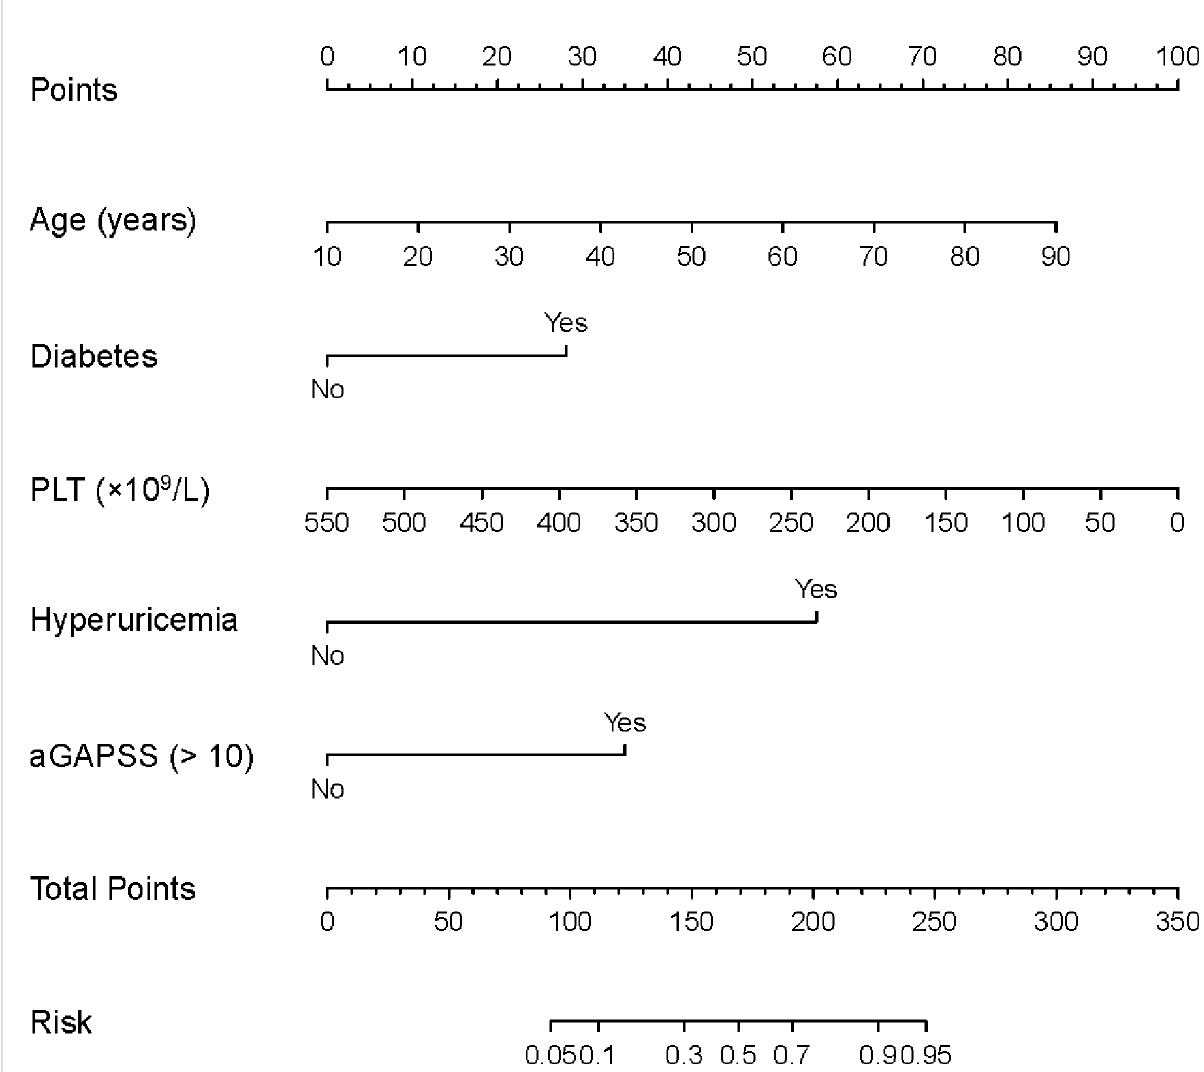
FIGURE 2 The nomogram for predicting the risk of IS in the training cohort. For each patient, we added up the points identi fi ed on the points scale for the fi ve risk factors. Then, the risk probability of IS was obtained according to the “ Total Points ” axis of the nomogram. APS, antiphospholipid syndrome; IS, ischemic stroke; aGAPSS, adjusted Global Anti-Phospholipid Syndrome Score; PLT, platelet